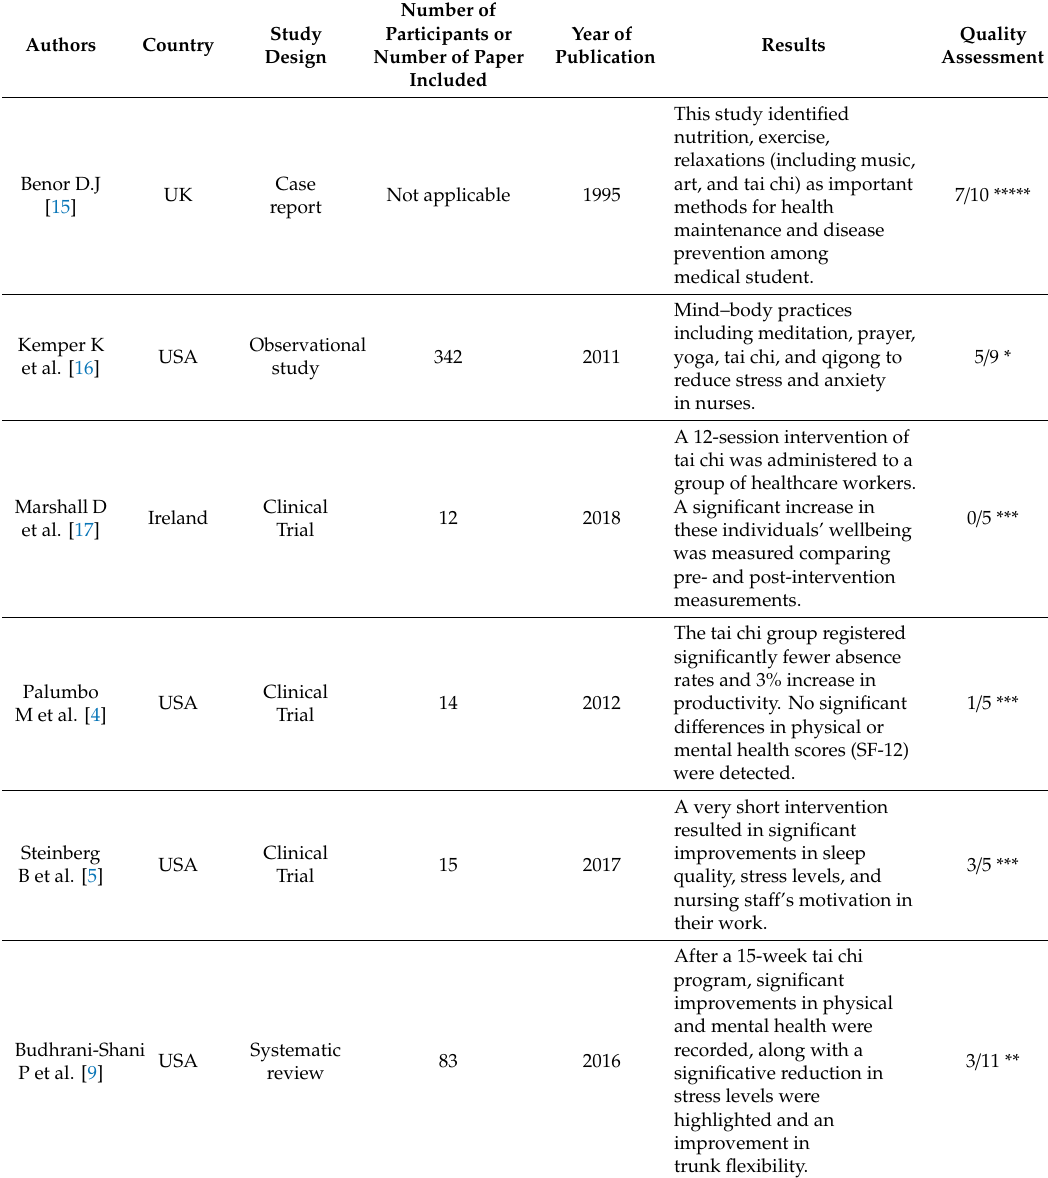
Table 1. Characteristics of the included